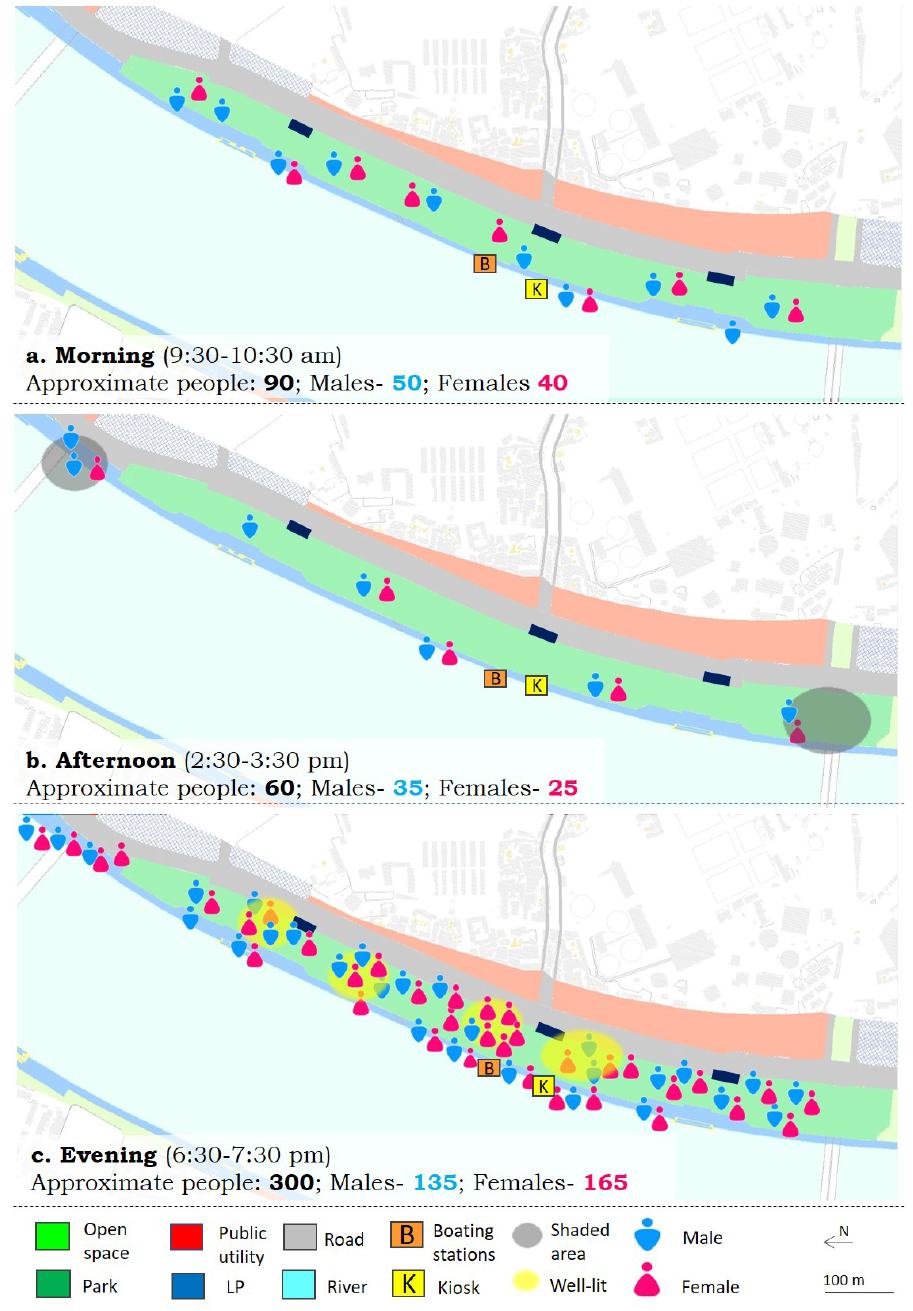
Figure 5. Gendered usage of space in Pocket 3. most poorly maintained spots among all the four pock- ets. The stretch is active only on Sundays due to Ravivari (Sunday Market), which is held in the vicinity. The crowd from Ravivari (Sunday Market) often spreads on both sides of Ellis Bridge and all the way up to the central plaza in the Walled